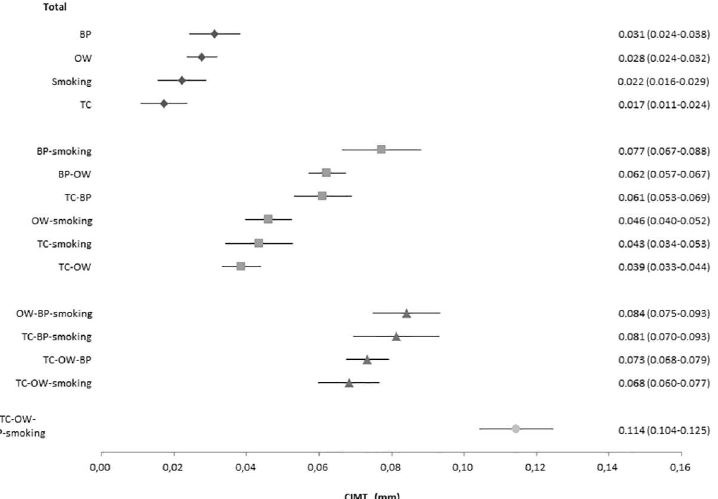
Fig 3. Relation between risk factor clusters and differences in CIMT (Overall). Each cluster was compared to individuals without any risk factor (referencegroup). CIMT, mean common carotid intima media thickness. BP, elevatedblood pressure; OW, overweight; TC, elevatedtotal cholesterol; smoking, current smoking.For most of the risk factors, the sum of the individual risk factor differences was smaller than the observedmean difference for the cluster in the overall analyses. For example,the mean difference in common CIMT for the blood pressure—smoking cluster was 0.077 mm, whereasthe sum of the individual risk factors was 0.053 (i.e., 0.031 + 0.022). A similar finding was found for the smoking-blood pressure- overweight cluster. This observation suggests synergeticeffects of risk factors on